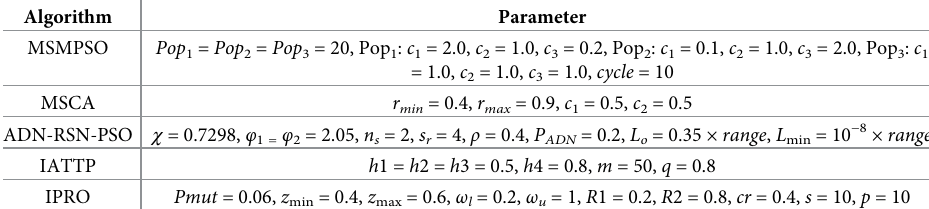
Table 6. Initial parameters setting of each